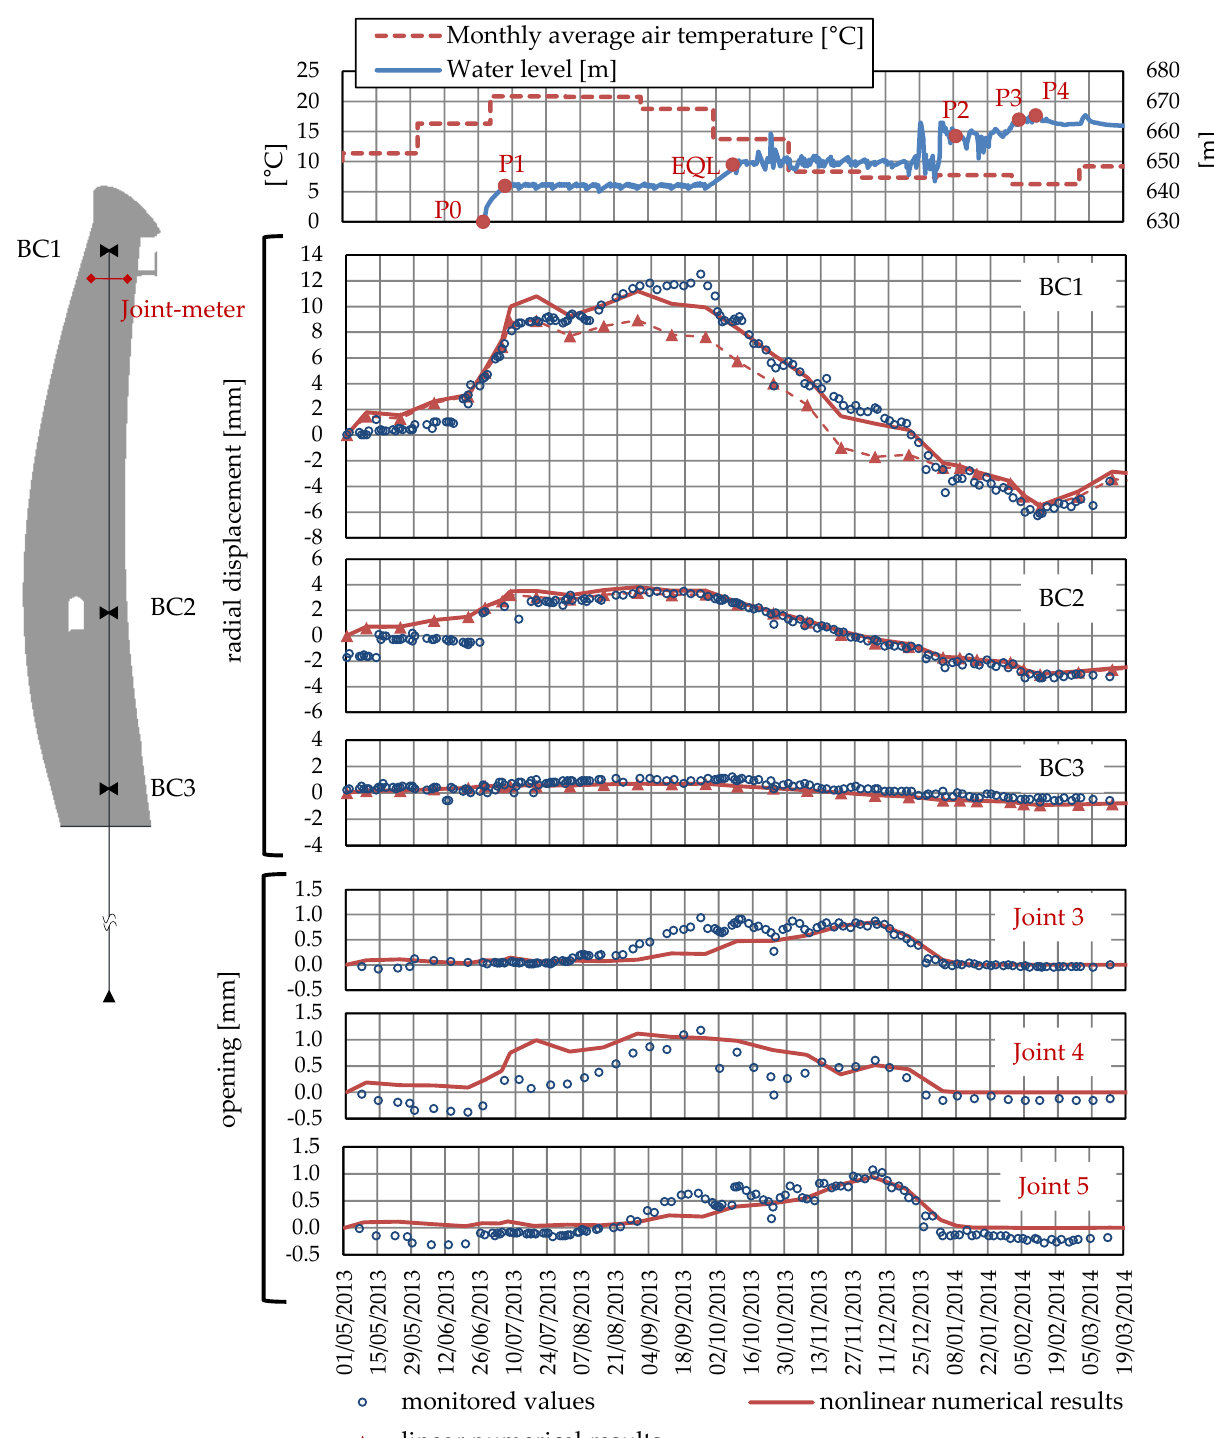
Figure 10. Monthly average air temperature, reservoir levels, and comparison of predicted and monitored displacements.